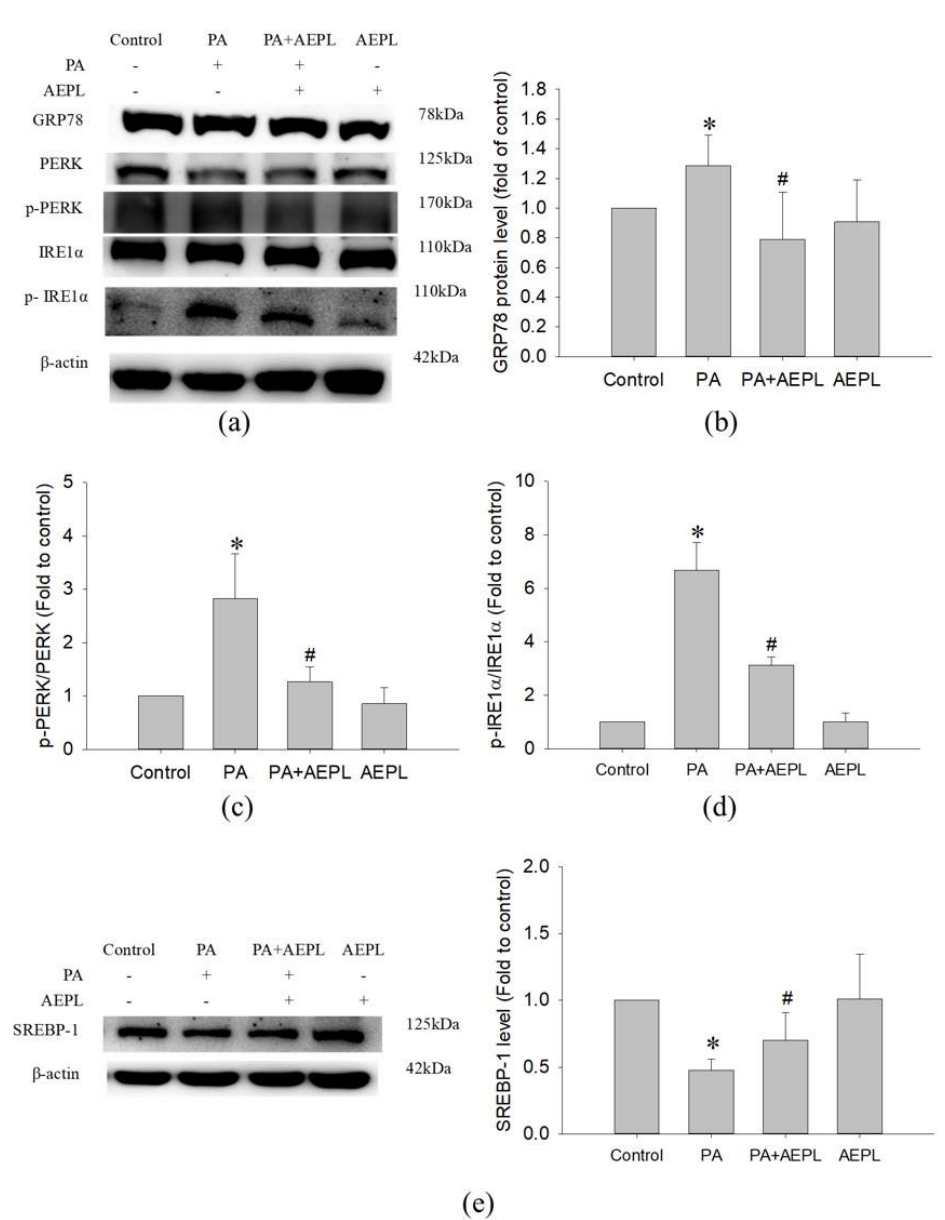
Figure 5. AEPL attenuated ER stress while PA exposure. ( a ) ER stress-related protein levels were analyzed by Western blotting. ( b – d ) GRP78, phosphorylated PERK, and phosphorylated IRE1 α were normalized to PERK, IRE1 α , and β -actin of each sample. ( e ) SREBP-1 level in each group was normalized to β -actin. All data were presented as mean ± SD of at least three independent experiments. * p < 0.05 vs. control cells; # p < 0.05 vs. PA-treated